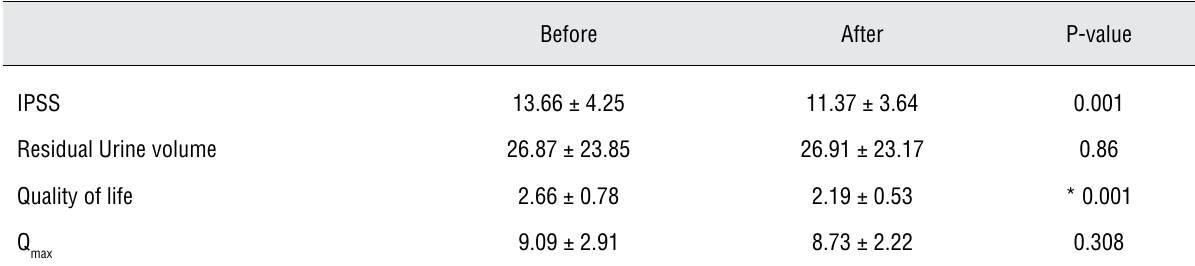
Table 2 - Mean values of variables before and after treatment of the placebo group. Before After P-value IPSS 13.66 ± 4.25 11.37 ± 3.64 0.001 Residual Urine volume 26.87 ± 23.85 Quality of